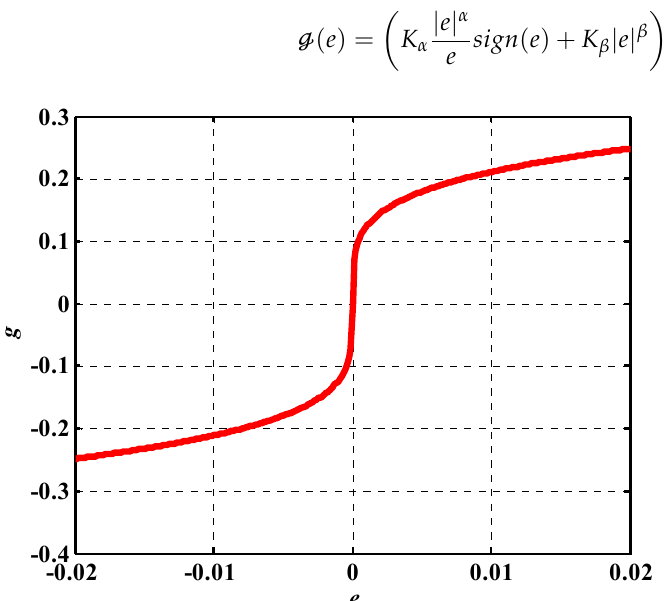
Figure 1. The ℊ function with parameters 𝛼 = 0.233,𝛽 = 0.334, 𝑘 (cid:3080) = 0.617 and 𝑘 (cid:3081) = 0.143 . Figure 1.